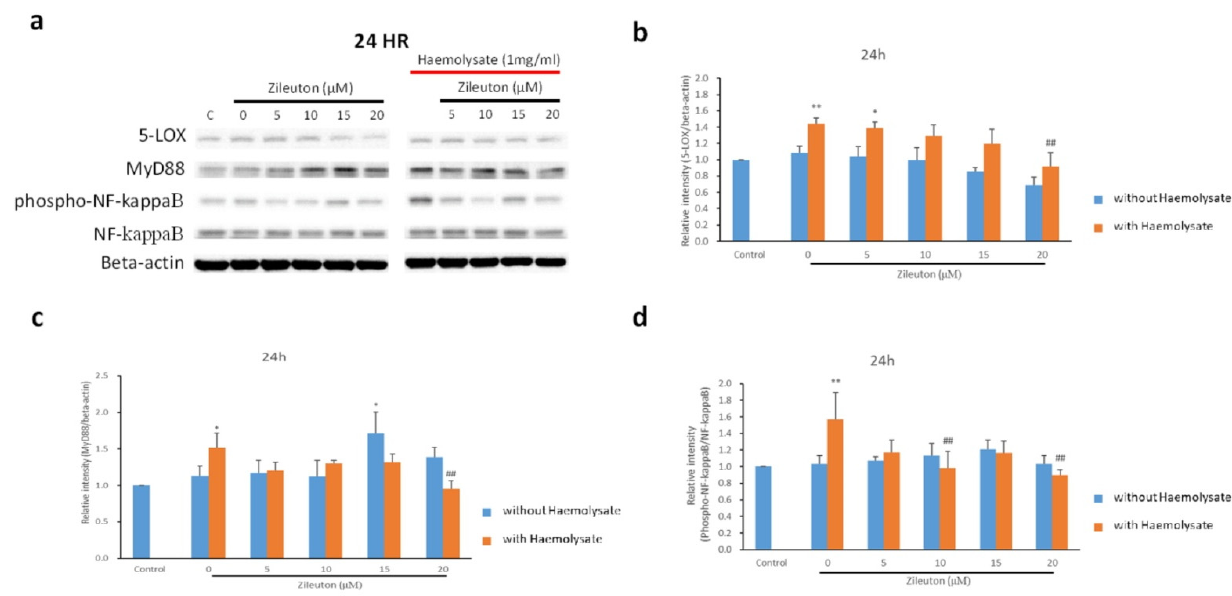
Figure 4. Western blot results for 5-LOX, MyD88, and phosphor-NF- κ B (pNF- κ B)/NF- κ B. ( a ) Western blot results for 5-LOX, MyD88, and pNF- κ B/NF- κ B. ( b ) Histogram illustrating the Western blot results for 5-LOX expression level. The x -axis represents the control group, haemolysate + vehicle, and haemolysate + different concentrations of zileuton; the y -axis represents the expression levels as the relative intensity of protein bands that appeared in the Western blot assay. The haemolysate + vehicle group and the haemolysate + 5 µ M zileuton group showed a higher expression level of 5-LOX than the control group. The expression of 5-LOX in the haemolysate + 20 µ M zileuton group was significantly lower than that in the haemolysate + vehicle group ( p < 0.01). There was no significant difference between the haemolysate + 20 µ M zileuton group and the control group. The haemolysate-induced overexpression of 5-LOX can therefore be inhibited by a high concentration (20 µ M) of zileuton (* p < 0.05, ** p < 0.01 compared with control; ## p < 0.01 compared with haemolysate + vehicle group, n = 3). ( c ) Histogram illustrating the Western blot results for MyD88. The haemolysate + vehicle group displayed a significantly higher expression level of MyD88 than the control group ( p > 0.05). The expression level of MyD88 in the haemolysate + 20 µ M zileuton group was significantly lower than that in the haemolysate + vehicle group ( p < 0.01). There was no significant difference between the haemolysate + 20 µ M zileuton group and the control group (* p < 0.05 compared with control; ## p < 0.01 compared with haemolysate + vehicle group, n = 3) ( d ) Histogram illustrating the pNF- κ B/NF- κ B ratio determined via Western blot assay. The activated NF- κ B, i.e., pNF- κ B, enhances the production of downstream pro-inflammatory cytokines. Herein, we measured the pNF- κ B/NF- κ B ratio via Western blot assay to determine the activation level of NF- κ B, which is directly proportional to the pNF- κ B/NF- κ B ratio. The haemolysate + vehicle group had a significantly higher pNF- κ B/NF- κ B ratio than the control group ( p < 0.01), while the haemolysate-exposed BV-2 cells treated with 10 and 20 µ M of zileuton showed a significantly lower pNF- κ B/NF- κ B ratio than those treated with the vehicle ( p < 0.01). However, there was no significant difference between the haemolysate + 10 µ M and + 20 µ M zileuton and the control groups (** p < 0.01 compared with control; ## p < 0.01 compared with haemolysate + vehicle group, n =